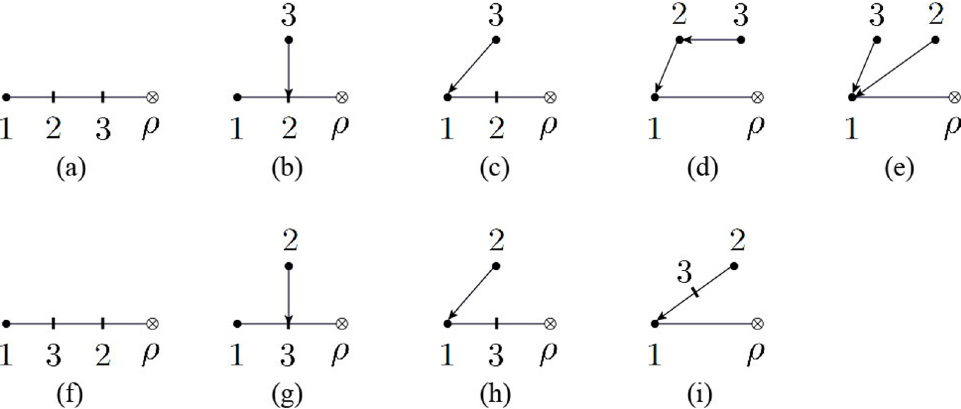
Figure 3 . Type-A graphs with three on-shell